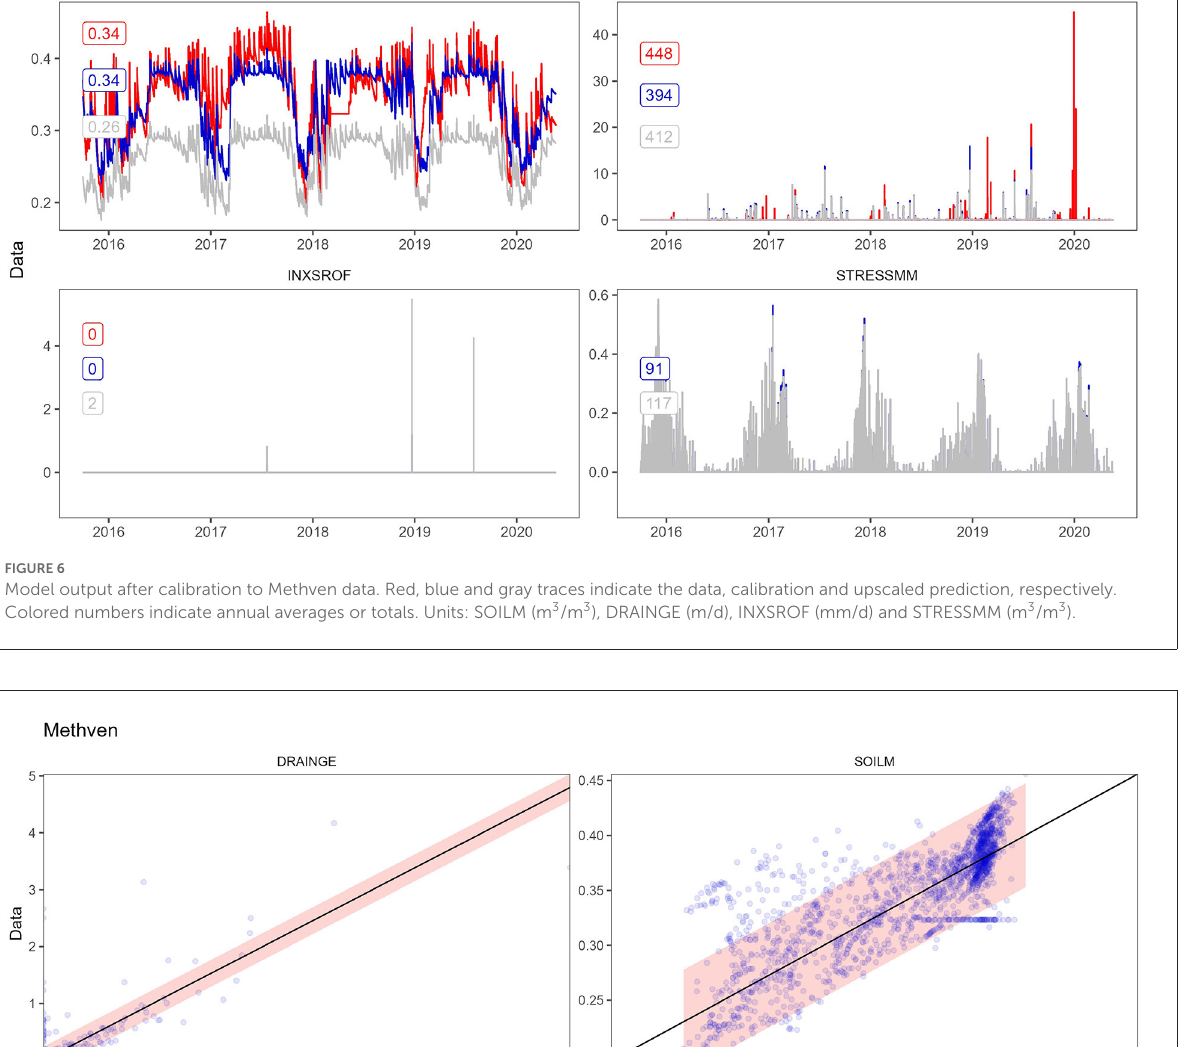
parameter set may also not be particularly near the median predicted value. See Figure A2 for an example. NSE and RMSE are given in Figure 9 for each of the four calibration data series (uncalibrated soil moisture, change in soil moisture, drainage and surface runoff). NSE is not defined for surface runoff (since the daily runoff “data” were all zero); the proportion of days with zero runoff was used instead (PZERO). The perfect fit value (1) is shown as a dotted line on the NSE and PZERO subplots. RMSE results for each data series